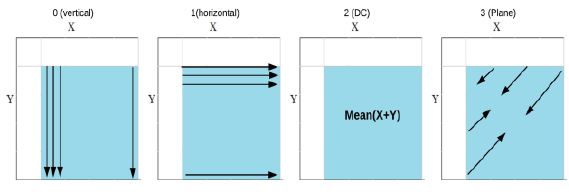
Figure 3. 16  16 intra-prediction modes in H.264.